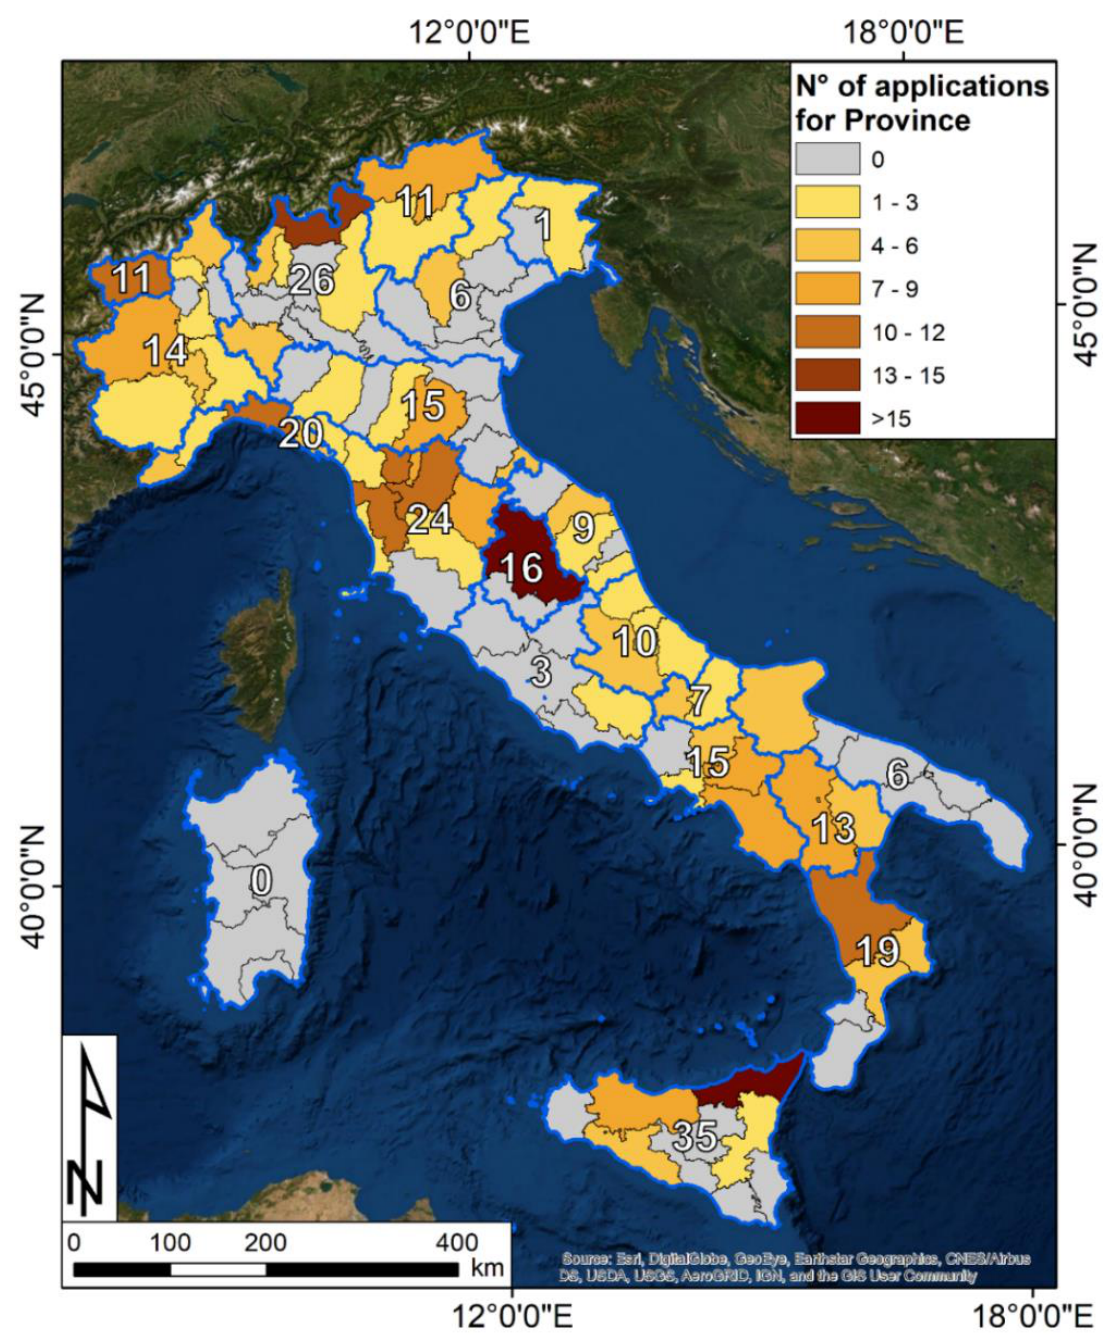
Figure 2. Distribution of Interferometric Synthetic Aperture Radar (InSAR)-related applications for landslide studies in Italy in the period 1999–2019. The total number of applications for each region is included as well. Multiple provinces and regions can be the target of a single work. National-scale applications are excluded. The background image is an ESRI World Imagery Map.